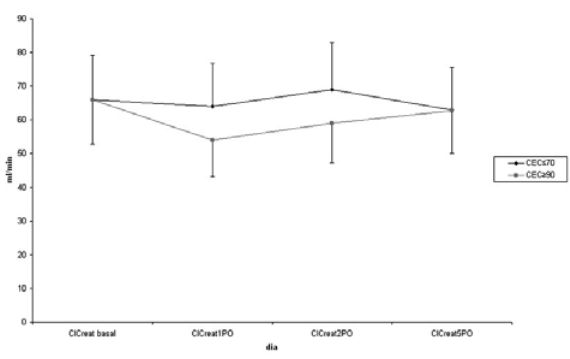
Fig. 1 - Alteração do clearance de creatinina ClCreatbasal=clearance de creatinina pré-operatório, ClCreat1PO=clearance de creatinina no primeiro pós-operatório, ClCreat2PO=clearance de creatinina no segundo pós-operatório, ClCreat5PO=clearance de creatinina no quinto